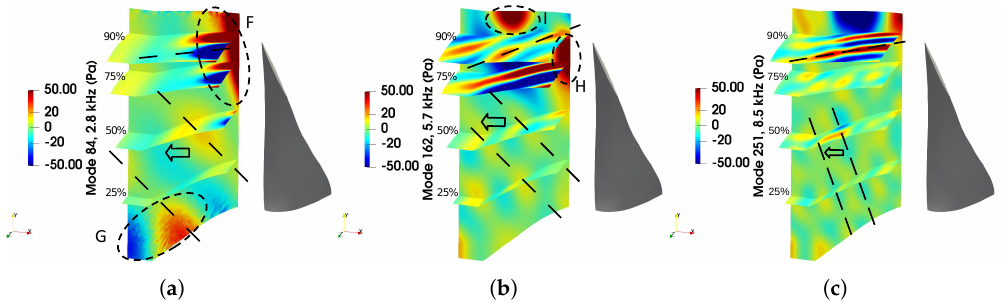
Figure 14. Temporal snapshots of three DMD modes ( t = 0.5 T ) in the upstream volume: ( a ) 2.8 kHz, ( b ) 5.7 kHz, ( c ) 8.5 kHz. The modes correspond to red crosses in Figure 13a. Dashed lines show the orientation of the wave front and the arrows show the axial propagation